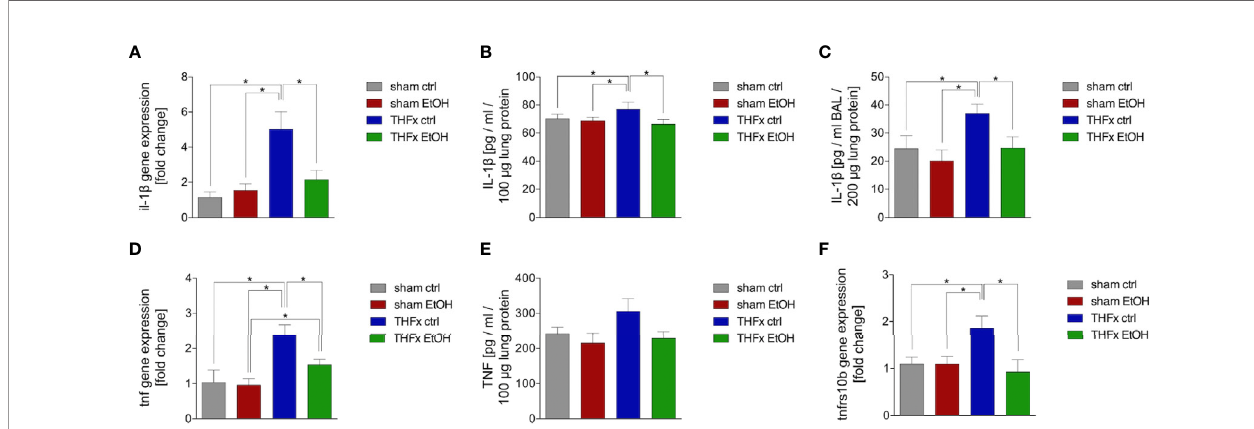
FIGURE 3 | Impact of acute ethanol intoxication (EI) on IL-1 b and TNF as well as Tnfrs10b after femoral fracture (Fx) and hemorrhagic shock (HS, THFx respectively). The animals received an intragastric gavage of either sodium chloride (ctrl, n = 14) or ethanol (EtOH, n = 14) to simulate an acute intoxication with alcohol. Two hours before the initiation of experiments, the animals in trauma groups underwent an Fx ( via osteotomy after the placement of an external fi xator) and a pressure-controlled HS with subsequent resuscitation with Ringer ’ s solution (THFx) via catheterized femoral artery ( n = 14). Sham groups underwent catheterization and received an external fi xator, but THFx was not induced ( n = 14). Twenty-four hours after the end of the experiment, mice were euthanized, and sampling was performed. (A) RT-qPCR of homogenized lung tissue has been performed. The relative gene expression of Il-1 b normalized to Gapdh was calculated by using the 2 − DD CT method. (B) Quanti fi cation of IL-1 b protein concentration in total lung tissue protein homogenates using mouse-speci fi c ELISA kits is shown. (C) Quanti fi cation of IL-1 b protein concentration in bronchoalveolar lavage fl uid (BALF) is represented. Brie fl y, to obtain BALF, via trachea, lungs were fl ushed with 1.1 ml of phosphate buffered saline and then 800 µl was withdrawn for the determination of total protein concentration and IL-1 b levels. (D) The relative gene expression of Tnf normalized to Gapdh after RT-qPCR was calculated by using the comparative threshold-cycle 2 − DD CT method. (E) Quanti fi cation of TNF protein concentration in total lung tissue protein homogenates using mouse-speci fi c ELISA kits is shown. (F) The relative gene expression of Tnfrs10b normalized to Gapdh was assessed via RT-qPCR and calculated by using the comparative threshold-cycle 2 − DD CT method. Data are presented as mean ± standard error of the mean; n = 7 in all groups, * p < 0.05 between indicated